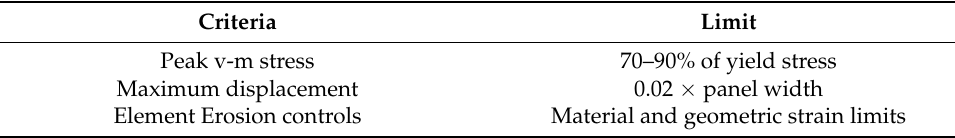
Table 5. Criteria for successful candidates.